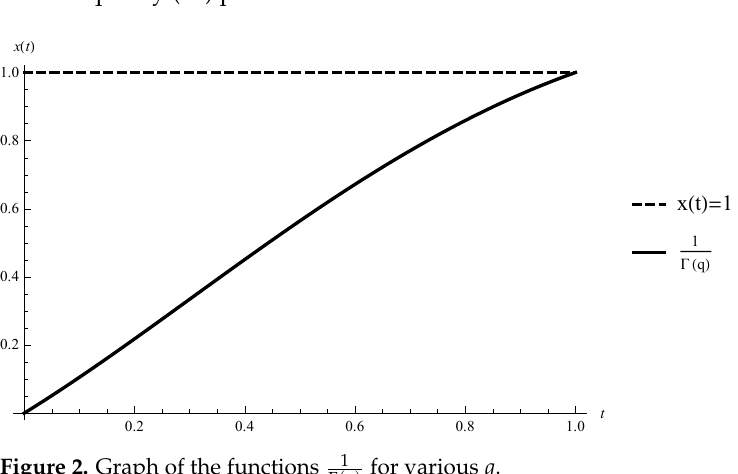
Figure 2. Graph of the functions 1 Γ